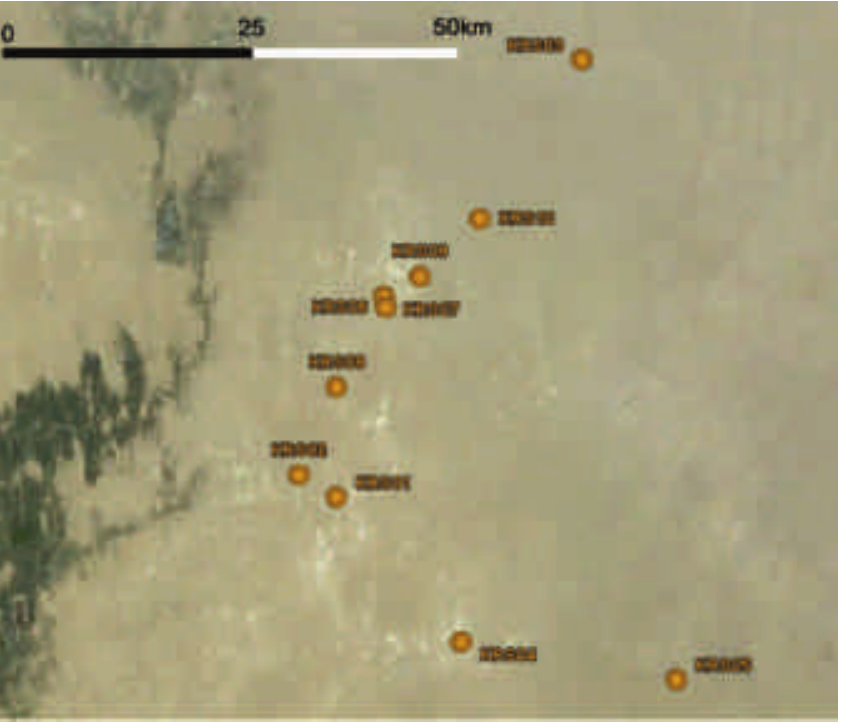
Figure 4 Sites located during the field survey sample area along the northern route. (Background © Google EarthTM mapping service)